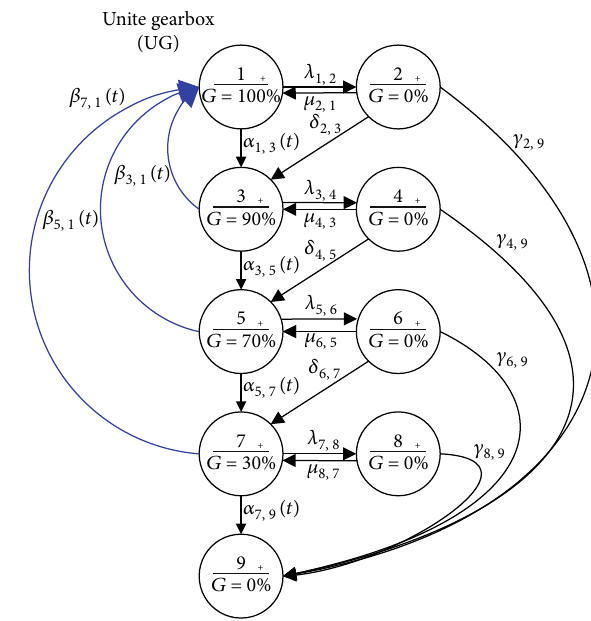
Figure 12: State-transition diagram of the unite